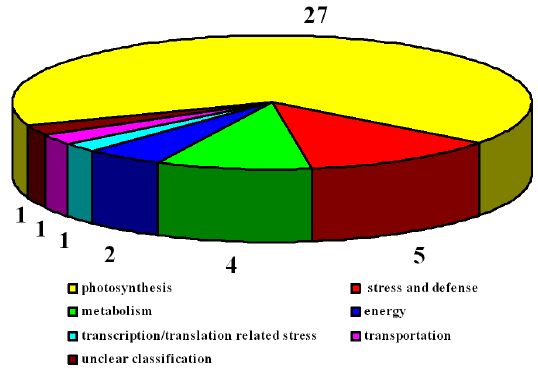
Figure 11. Functional categorization of proteins in Robinia pseudoacacia diploid (2×) plants under salt stress. Digits indicate the protein number of each functional